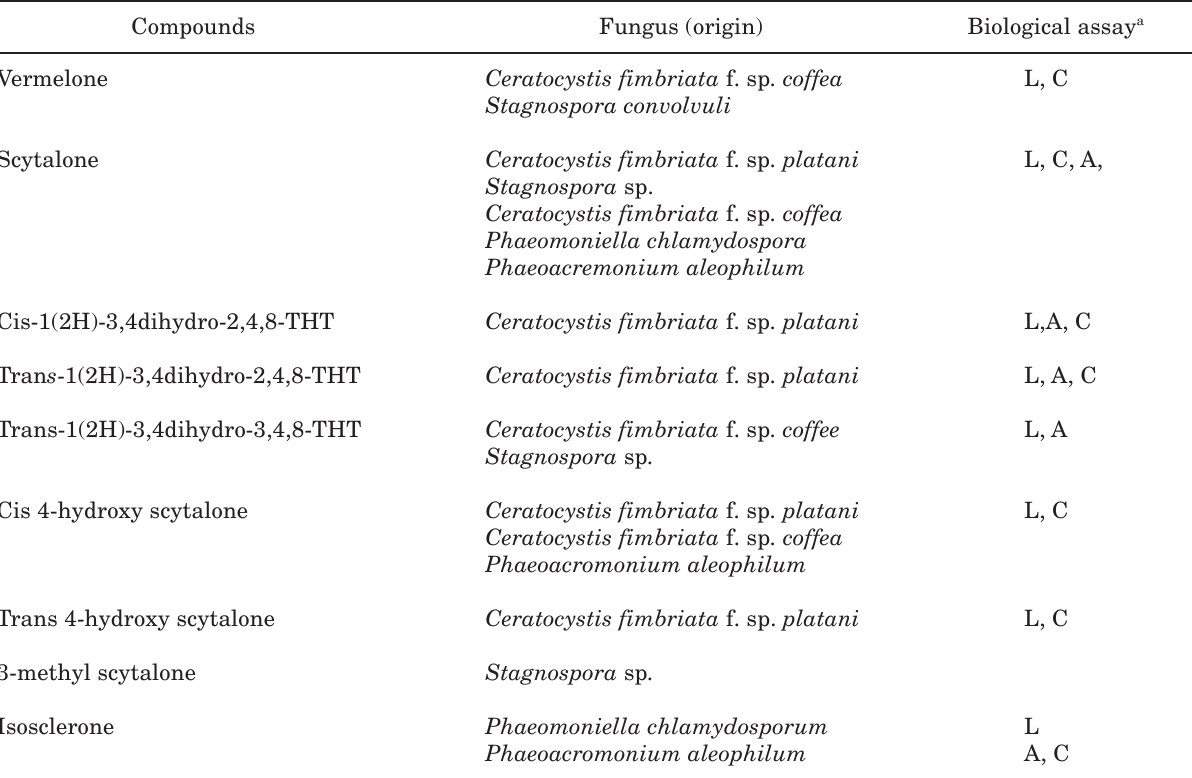
Table 1. Naphthalenone derivatives isolated from fungi with the corresponding biological assays.